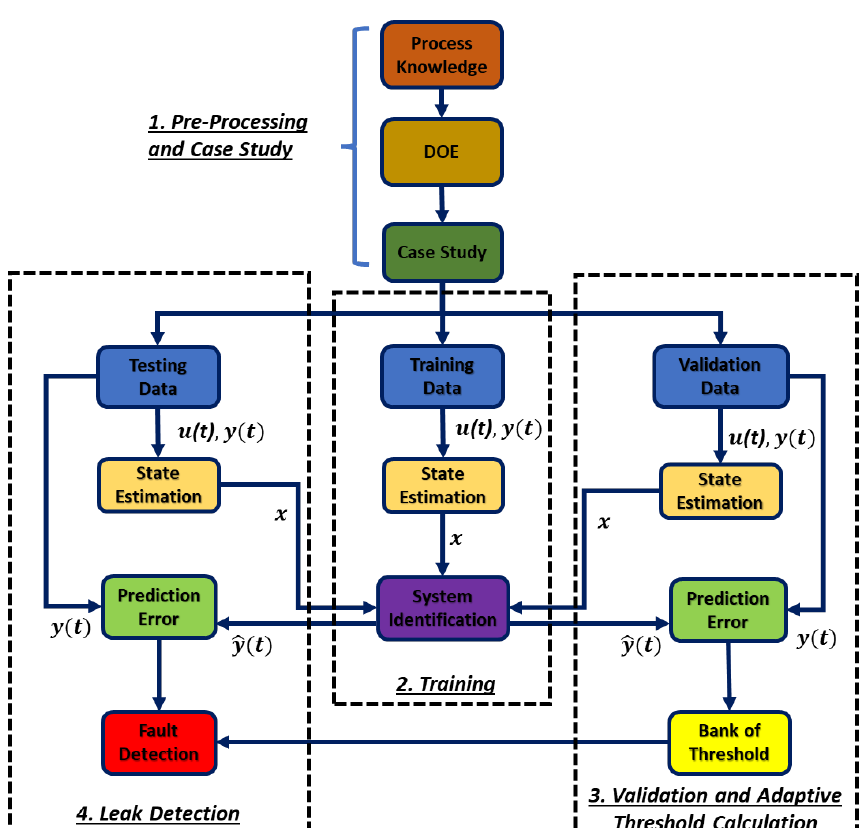
Figure 2. Novel methodology of adaptive threshold-based leak detection (ATBLD).